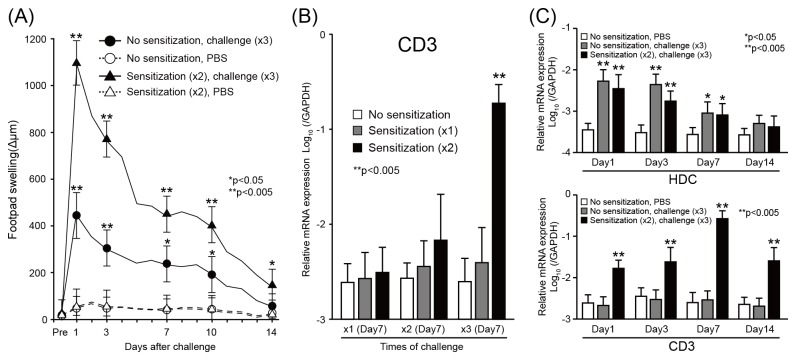
Footpad swelling and expression of T-cell markers in Pd-induced allergic mice.(A) Time course of footpad swelling under different conditions of sensitization and challenge. BALB/c mice were sensitized twice with 125µl of 10 mM Pd and 10 µg/ml LPS and then challenged three times with 25 µl of 10 mM PdCl2 (closed triangle) or PBS (open triangle) (n=7). In addition, mice were challenged three times with Pd (closed circle) or PBS (open triangle) without sensitization (n=10). Changes of footpad thickness were measured before and 1, 3, 7, 10 and 14 days after the last challenge of Pd. Data were indicated mean ± standard deviation (SD). Statistical significance was tested by unpaired Student’s t-test. (B) Expression levels of CD3ε mRNA were dependent upon sensitization condition. Mice were treated with different sensitization and challenge conditions (n=7). CD3ε expression was measured by qPCR 7 days after the last challenge. Bars and error bars indicate mean ± standard deviation. Statistical significance was only detected in mice administered two sensitizations and three challenges. (C) Time course of gene expression for histidine decarboxylase (HDC) and CD3ε in Pd-induced allergy mice. Expression of HDC and CD3ε were measured by qPCR at different time points after the last challenge. Data indicates mean ± SD (n=10). Statistical significance was tested by unpaired Student t-test (*p<0.05, **p<0.005).